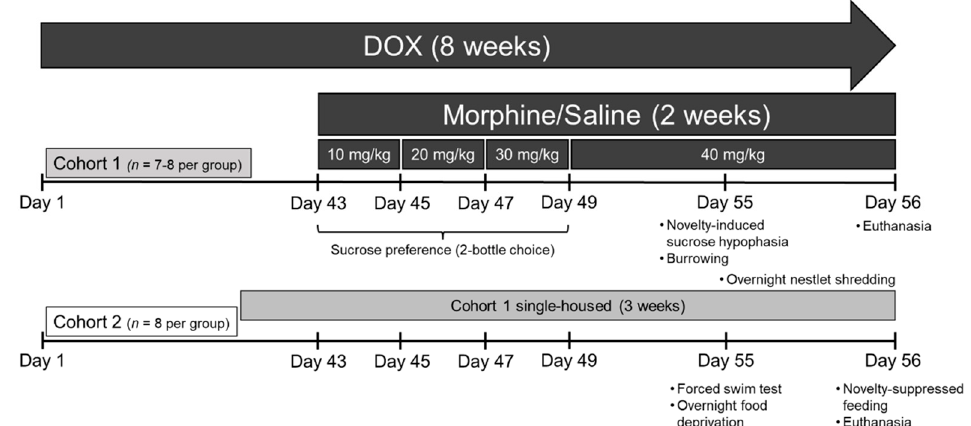
Figure 1. In vivo experimental timeline. Tat(+) and Tat(–) (control) mice were divided into two behavioral cohorts and administered doxycycline (DOX)-containing chow throughout the entire experiment (8 weeks) to induce Tat expression (or control for off-target effects). During the last two weeks of DOX administration, all mice were administered ramping morphine (10–40 mg/kg, increasing by 10 mg/kg/2 day, s.c., b.i.d.) or saline. Cohort 1 mice were single-housed for 1 week to acclimate before morphine administration and remained single-housed till the end of the